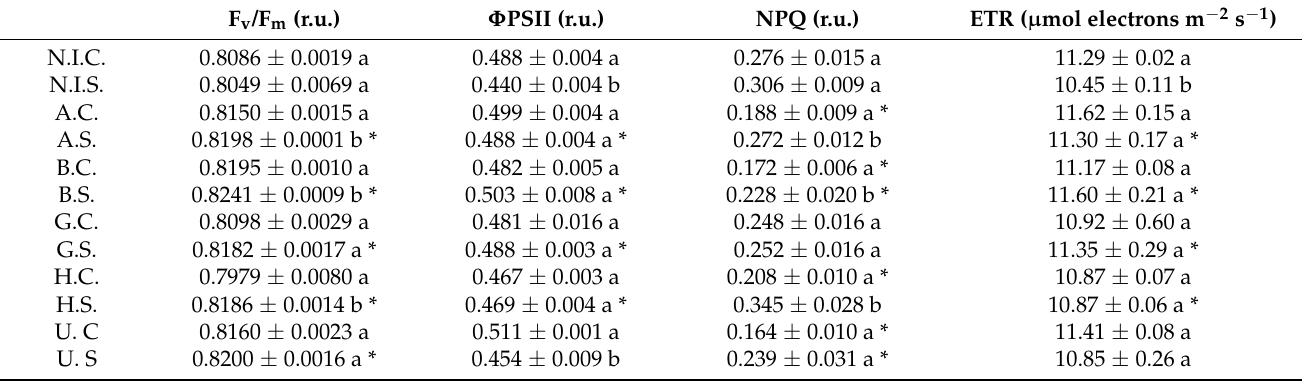
Table 4. Chlorophyll fluorescence parameters, maximal quantum efficiency (F v /F m ) measured in dark-adapted leaves and quantum efficiency of PSII photochemistry ( Φ PSII), non-photochemical quenching (NPQ), and electron transport rate (ETR) measured at steady state with actinic light illumination of 55 µ mol photons m − 2 s − 1 in B. napus cv. SY Saveo plants grown for 30 days on non-saline soil (C) or saline soil (S). Plants were inoculated with plant growth-promoting bacteria (A = A. brasilense , B = B. ambifaria , G = A. globiformis , H = H. seropedicae , U = Pseudomonas sp. UW4) or not (N.I. = non inoculated). Different letters mean significant differences within the same bacterial treatment. Significant differences between inoculated or non-inoculated plants grown at the same soil conditions are marked as * ( p < 0.05) ( n = 4). F v /F m (r.u.) Φ PSII (r.u.) NPQ (r.u.) ETR ( µ mol electrons m − 2 s − 1